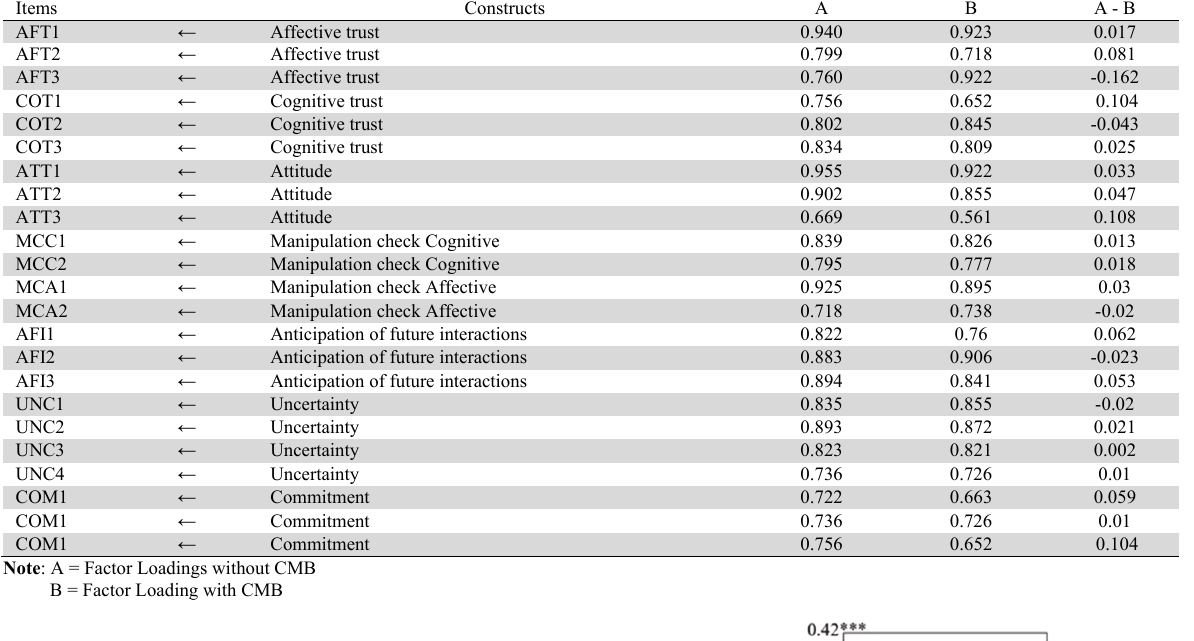
The summary of examining different factors